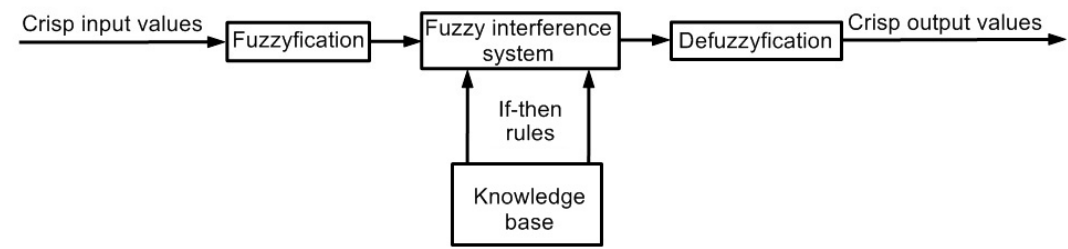
Figure 2. The scheme of fuzzy inference system (FIS) (fuzzy inference system) functioning.